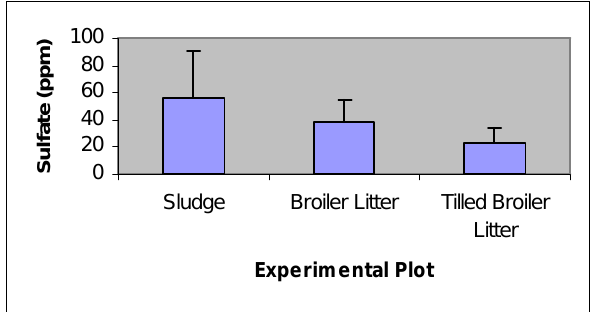
Figure 1: Sulfate levels (ppm) detected within the experimental plots. A significant difference ( p <0.05) is detected between plots containing sludge and tilled broiler